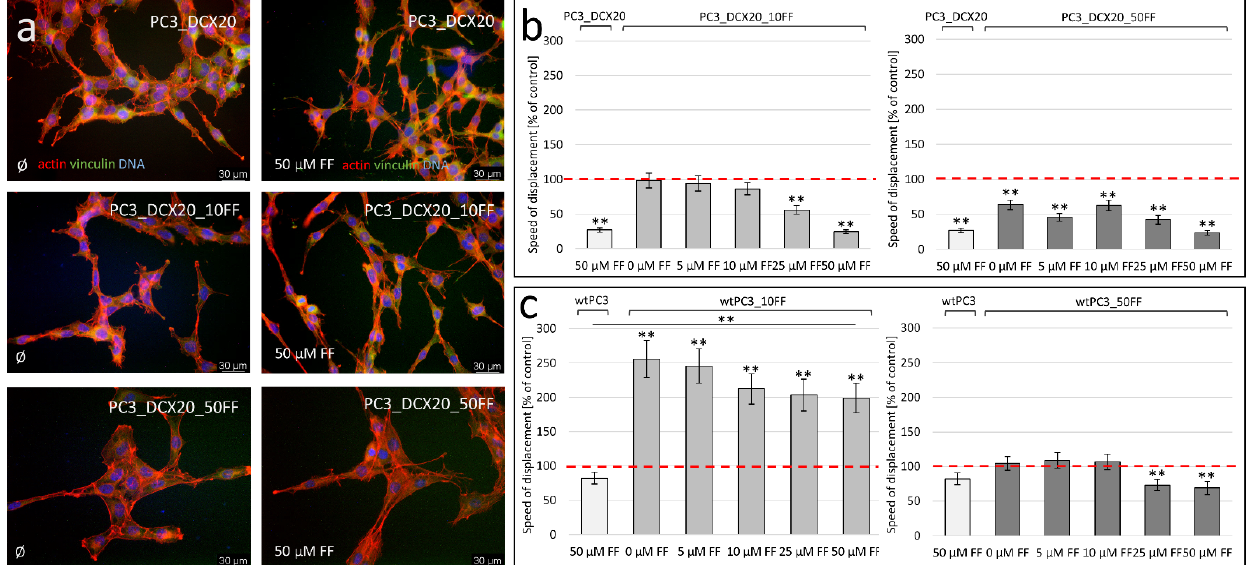
Figure 6. Long-term fenofibrate effects on the invasiveness of PC3 cells. ( a ) Morphology